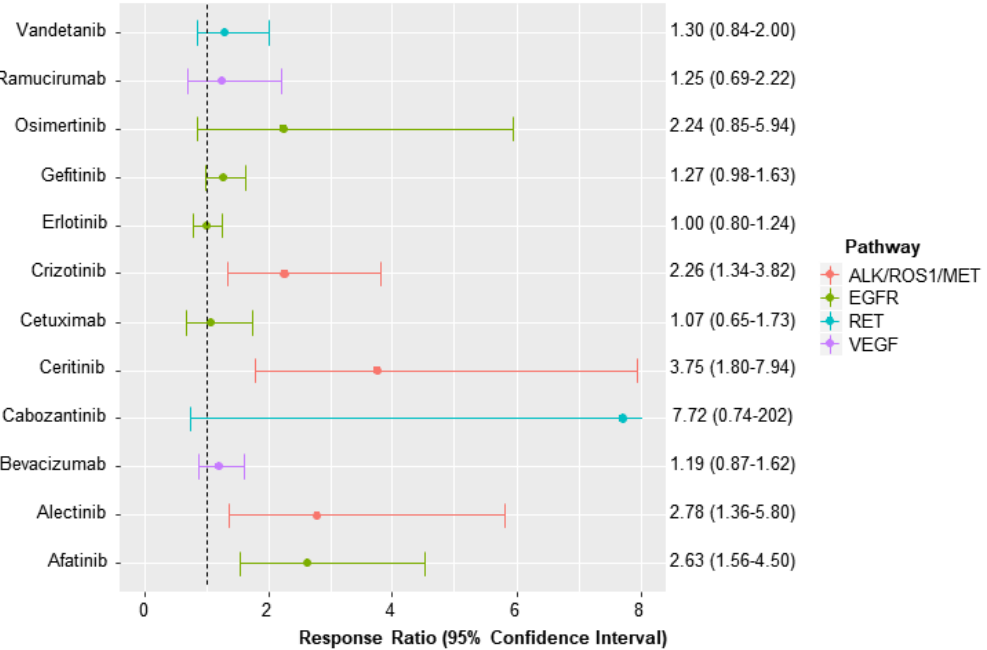
Figure 1. Network geometry of comparisons for overall response rate (ORR) and progression-free survival (PFS).